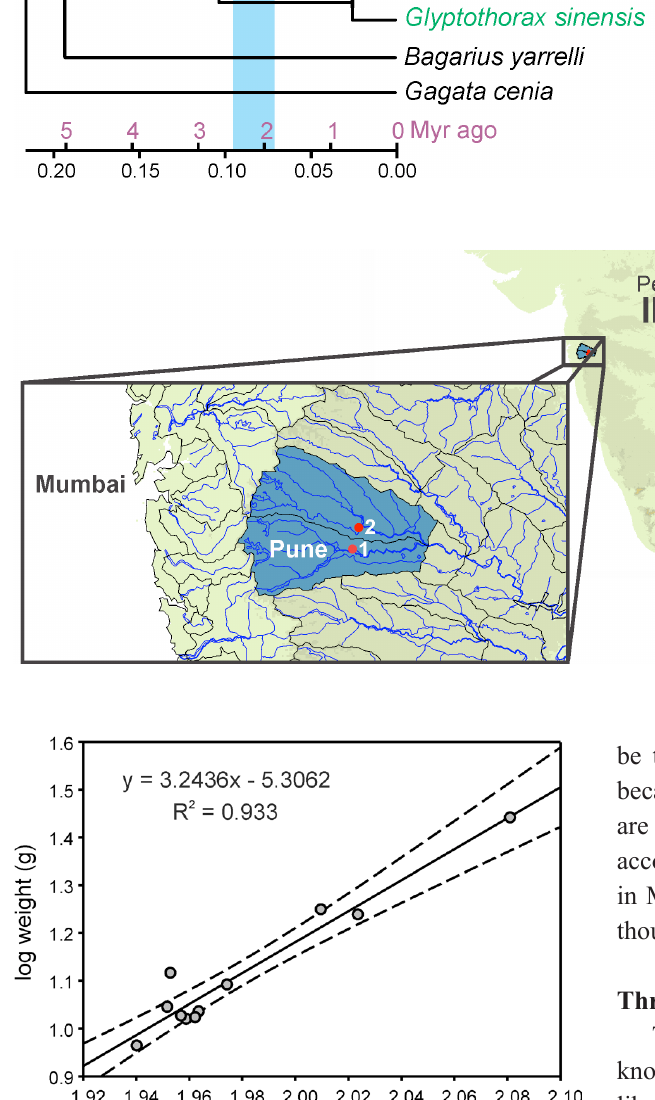
Figure 3. Molecular dating of Glyptothorax poonaensis based on maximum likelyhood analysis of cyt-b gene and the molecular calibrations available for divergence time between Gagata cenia and Bagarius yarrelli and between Bagarius yarrelli and Glyptothorax fokiensis (Peng et al. 2006). White bars on each node represent the 95% confidence interval of divergence time. Color code for species names as per Figure 2.